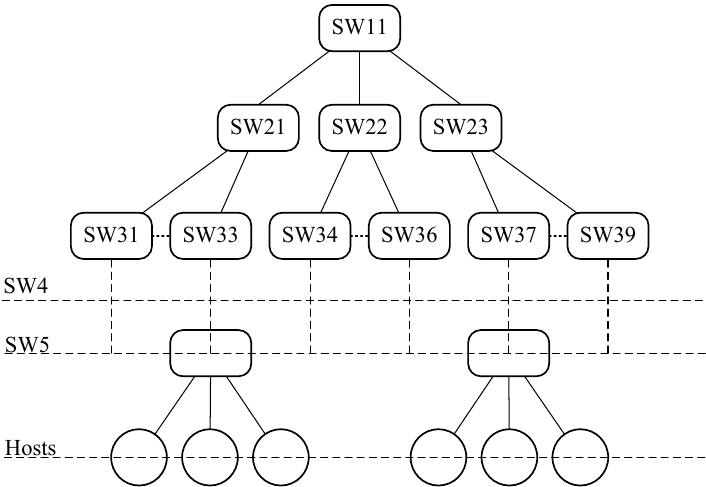
Figure 8. Network Scenario 1: Tree,5,3.